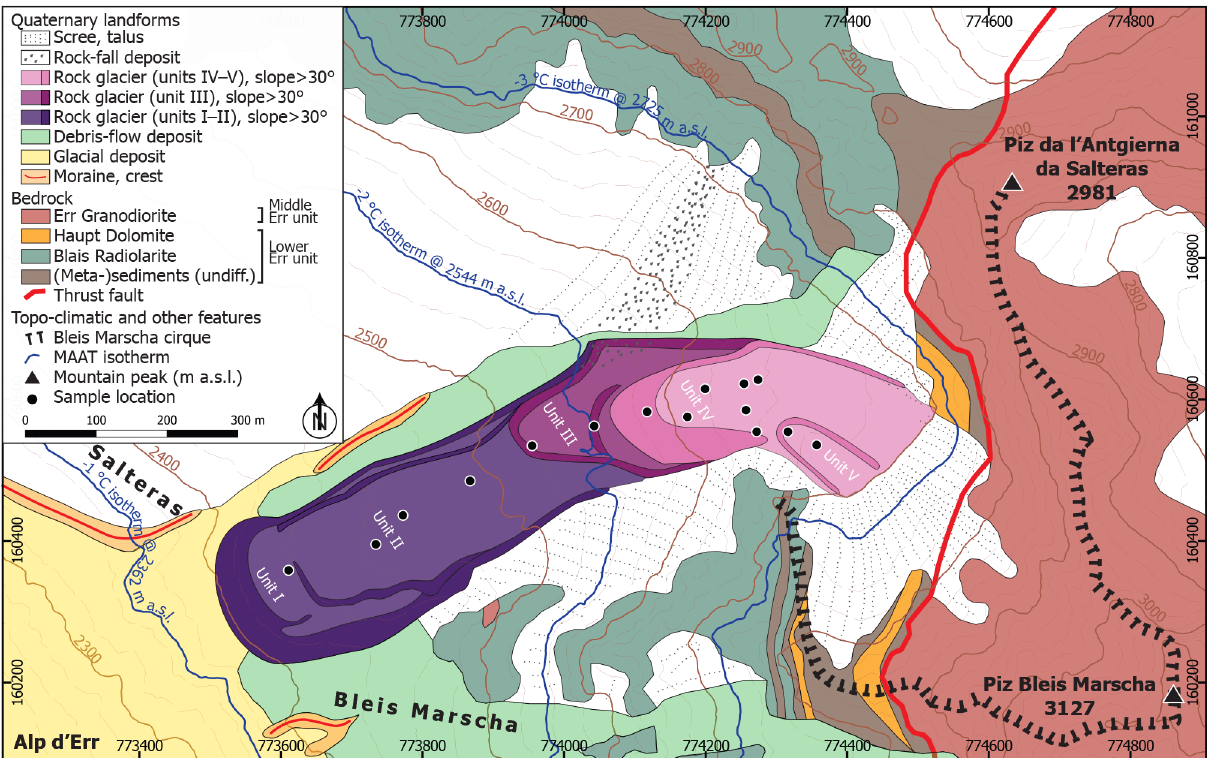
Figure 3. Quaternary features and main lithologies in the Bleis Marscha cirque. Bedrock map modified from Cornelius (1932). A subhorizon- tal thrust separates the crystalline Middle Err unit from the sedimentary Lower Err unit. Present-day mean annual air temperature (MAAT) isotherms are drawn according to Frauenfelder et al.